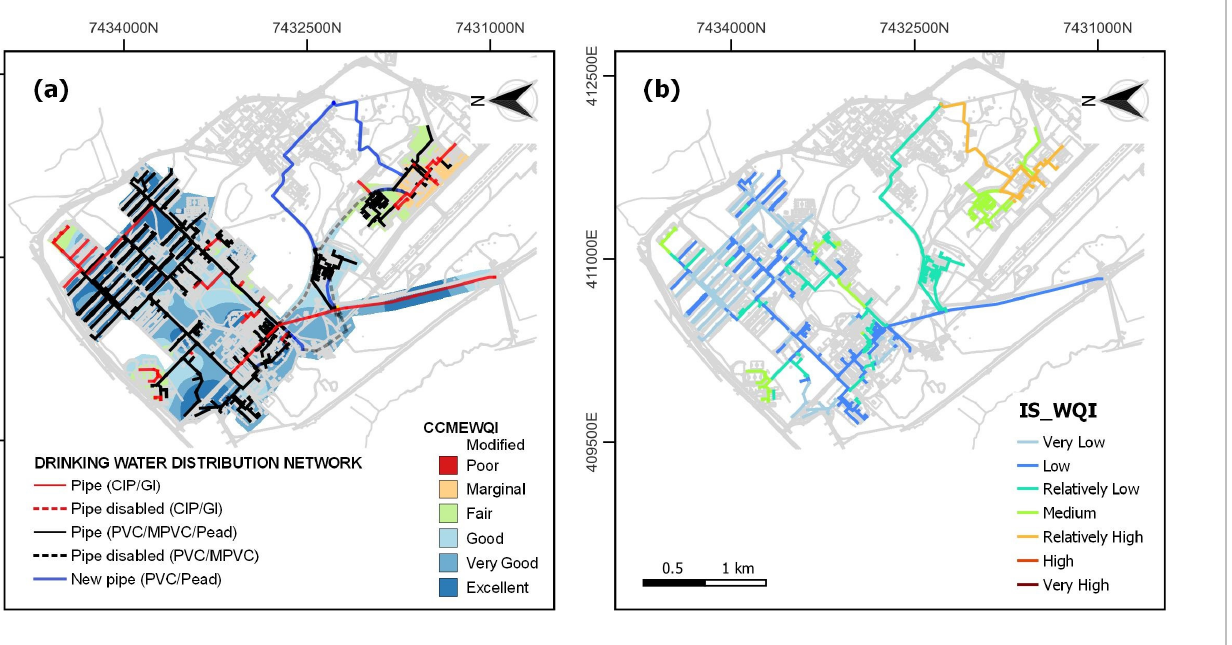
Figure 4. Qualitative/social consequence: ( a ) IDW interpolation—water quality; ( b ) ISWQI impact degree.